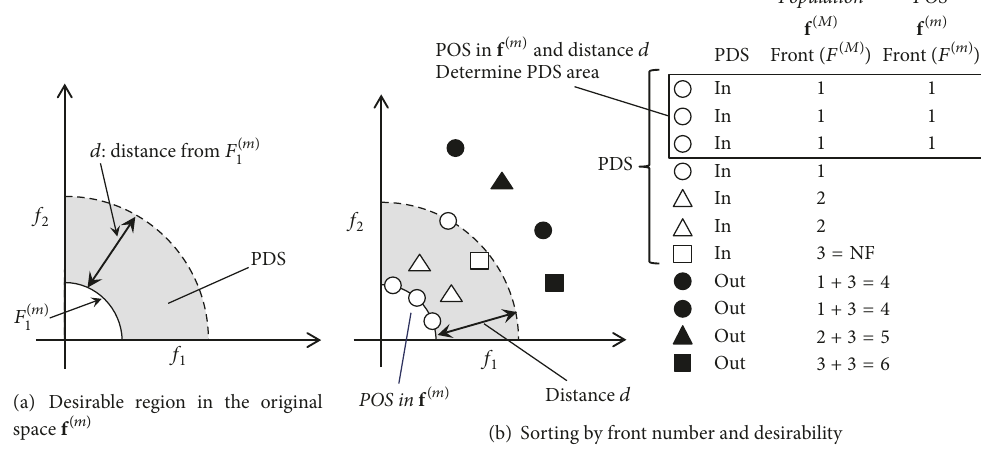
Figure 1: Region of practically desirable solutions with preferred values in variable space located within at most a distance 𝑑 from the Pareto optimal set computed in the original objective space f (𝑚) . Sorting by desirability with respect to the original space f (𝑚) and front number in the extended space f (𝑀)